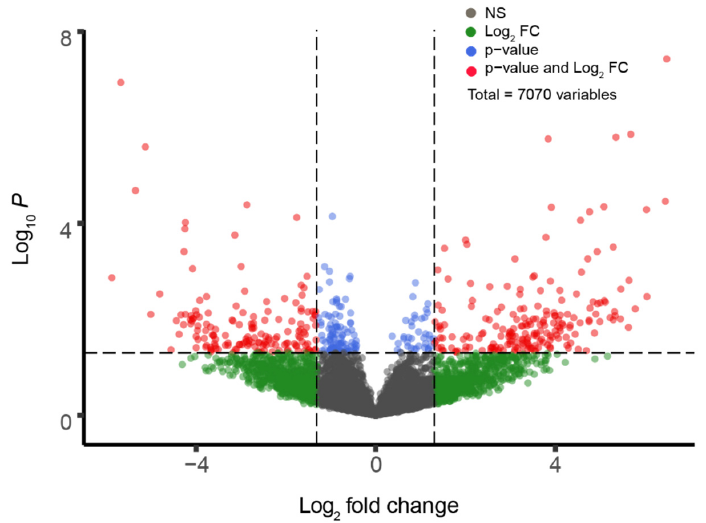
Figure1. Geneexpressioncomparisonbetweenhealthy-andAmyotrophicLateralSclerosis(ALS)-spinal Figure 1. Gene expression comparison between healthy- and Amyotrophic Lateral Sclerosis (ALS)- tissue. Volcano Plot depicting di ff erentially expressed genes between Healthy spinal tissue and spinal tissue. Volcano Plot depicting differentially expressed genes between Healthy spinal tissue ALS-a ff ected grey matter tissue from GSE833, discriminated based on p -value and log2(fold-change) and ALS-affected grey matter tissue from GSE833, discriminated based on p-value and log2(fold- change) at an α level of 0.05 and logFC cutoff of 1.3. Colored dots correspond to individual genes at an α level of 0.05 and logFC cuto ff of 1.3. Colored dots correspond to individual genes whose whose expression differences were significant based on both p and logFC value (red dots), only p- expression di ff erences were significant based on both p and logFC value (red dots), only p -value (blue Genes 2020, 11, x FOR PEER REVIEW value (blue dots), only logFC (green dots), or not significant (grey dots) in either. dots), only logFC (green dots), or not significant (grey dots) in either.